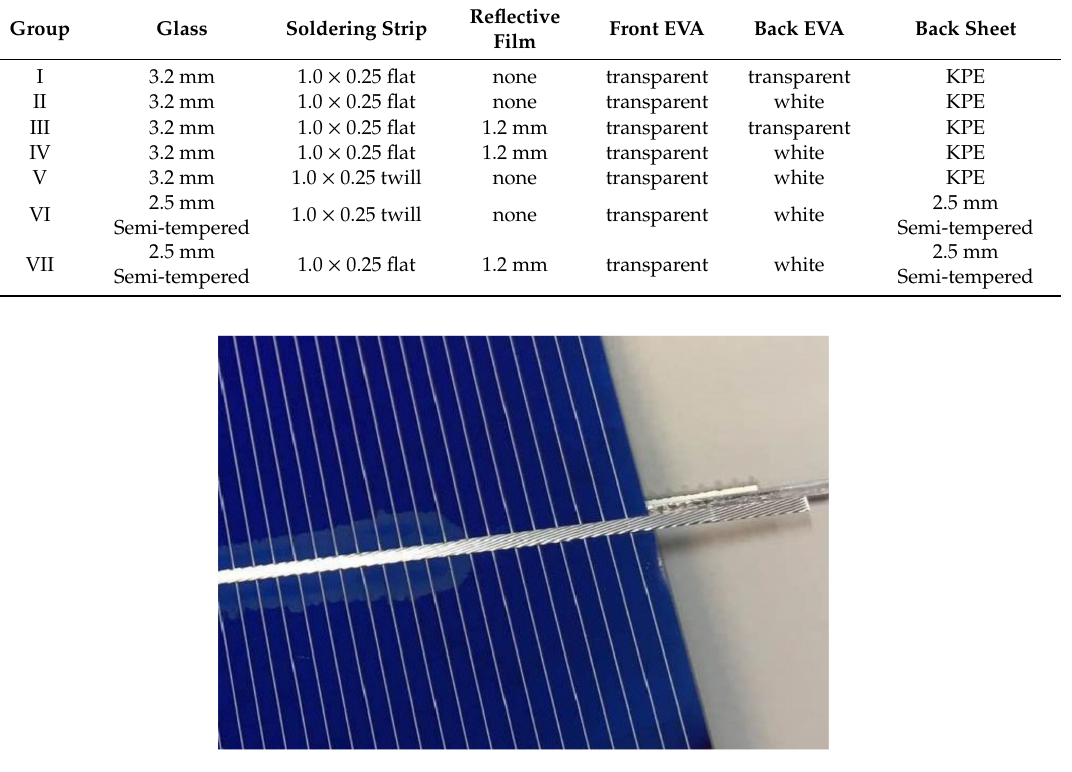
Figure 9. The schematic diagram of the twill soldering strip.